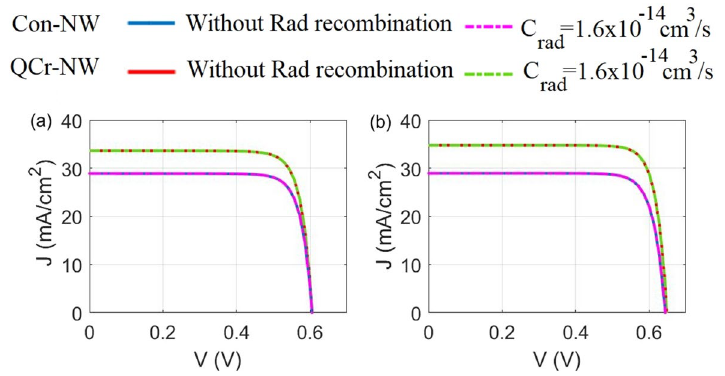
Figure 11. J–V characteristics with and without radiative recombination for the studied designs in the ( a ) axial and ( b ) core–shell junctions.